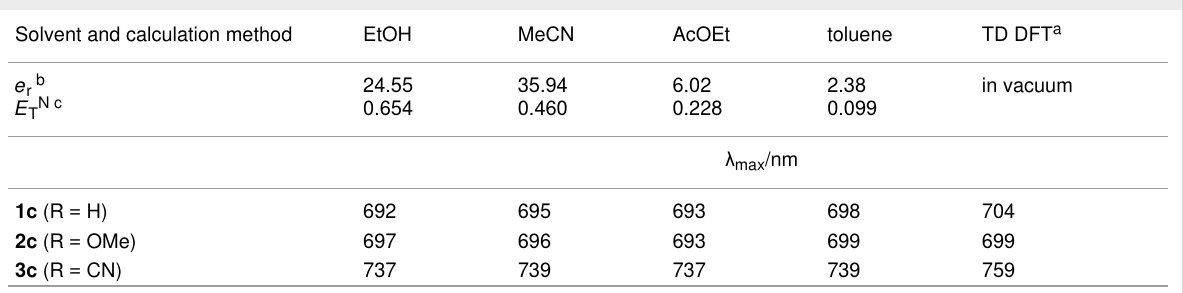
Table 1: Wavelengths of absorption maxima of the closed forms of photochromic triazoles. Solvent and calculation method